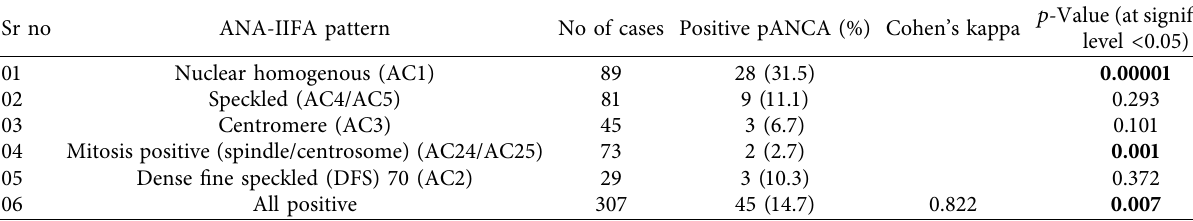
Table 2: ANA-IIFA pattern results versus pANCA positivity.